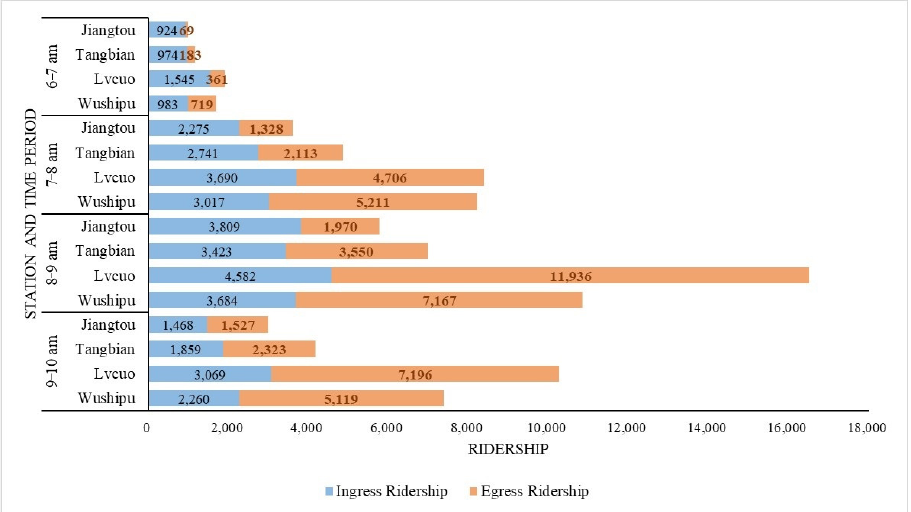
Figure 5. Ridership temporal distribution of selected stations.